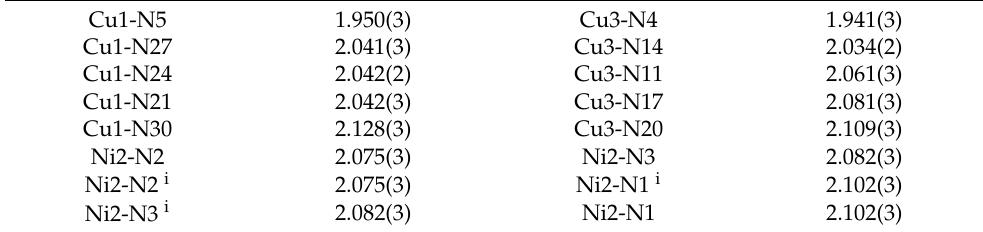
Figure 5. The structure of [Cu(tren)(NCS)] 4 [Ni(NCS) 6 ] ( 3 ) with the thermal ellipsoids at 30% proba- bility. Hydrogen atoms are omitted for clarity. Table 4. Selected bond lengths [Å] for 3 .